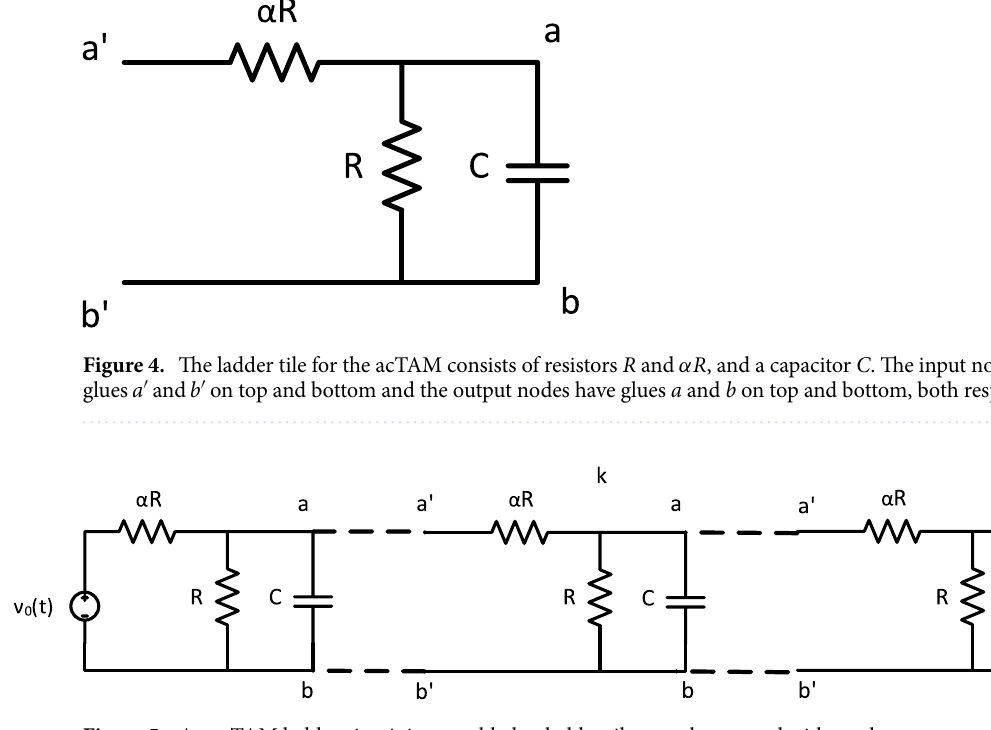
Figure 5. An acTAM ladder circuit is assembled as ladder tiles attach to a seed with a voltage source ν 0 ( t ) and subsequently, each other as long as the voltage across the RC pair at the terminus is at least τ . In addition, the hybridized glues at the top (a–a ′ ) and bottom (b–b ′ ) bind the assembly together. Nodes are labeled k and the terminal (last) node n